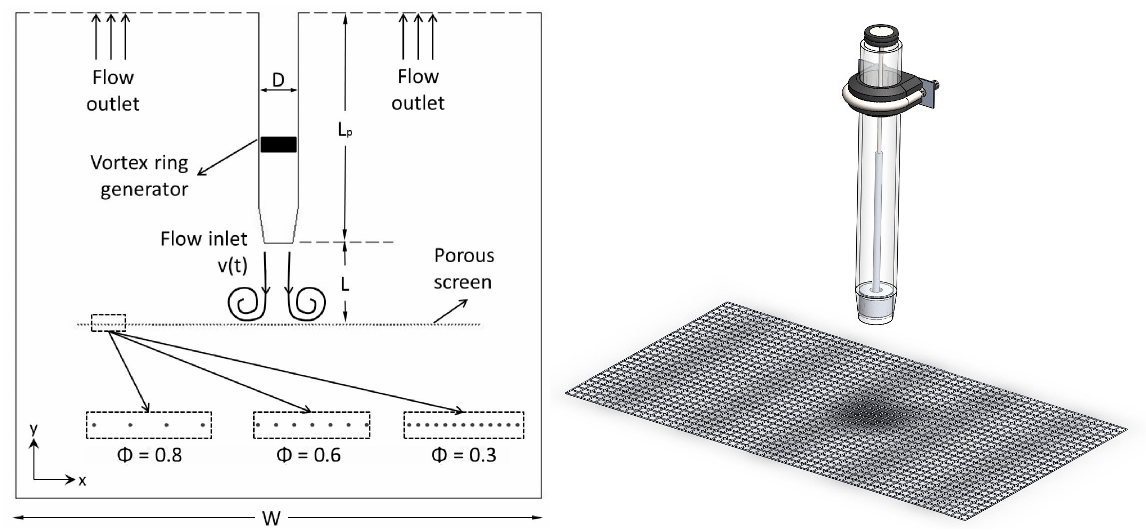
Figure 1. A schematic configuration of the simulation model, including the vortex ring generator and the porous screen. Governing Equations: Trapezoidal velocity profiles are assigned at the inlet of the air jet as shown in Equations (1)–(3). The maximum velocities for each case are, respectively, 0.32, 0.80, and 1.32 m/s. The Reynolds number of the air jet is defined as a function of velocity ( U max ), the kinematic viscosity of air at room temperature ( ν ), and the diameter of the piston ( D p ). Therefore, the related Reynolds numbers for these velocities are 700, 1800, and 3000,